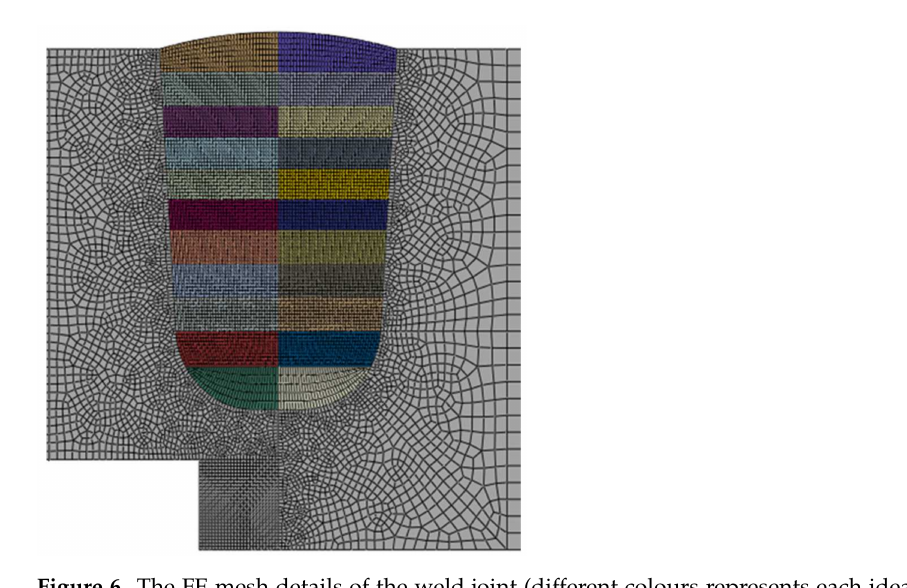
Figure 6. The FE mesh details of the weld joint (different colours represents each idealised weld deposition, which in total counts for 22 welding passes).